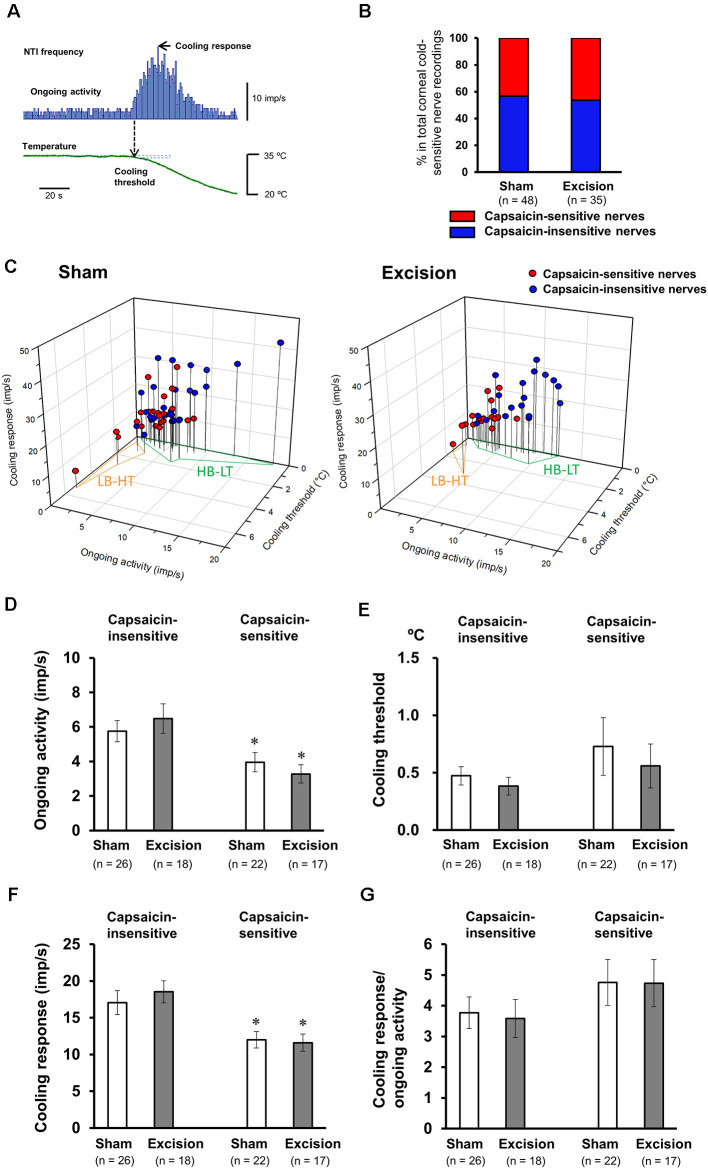
Firing characteristics of the cold-sensitive nerves responsive to capsaicin stimuli. (A) Representative nerve terminal impulse (NTI) frequency before and during cooling stimulation. (B) The proportion of nerve terminals responsive to capsaicin in the total recordings of the cold-sensitive nerves in the sham-operated and gland excision groups. (C) Individual recordings of the cold-sensitive nerves in the cornea dissociated from the sham-operated (left panel) and gland excision groups (right panel) plotted according to ongoing activity (x-axis), cooling response (y-axis), and cooling threshold (z-axis). The blue and red plots represent the capsaicin-insensitive and capsaicin-sensitive nerves, respectively. Areas enclosed in the orange line and green line correspond to the low-background activity-high threshold (LB-HT) and high background activity-low threshold (HB-LT) cold thermoreceptors, respectively. (D–G) Average values of the ongoing activity (D) cooling threshold (E), cooling response (F), and the ratio of cooling response to ongoing activity (G). Each column and vertical bar represent the mean ± SEM. *P < 0.05 vs. capsaicin-insensitive group (two-way ANOVA followed by Dunnett’s test).